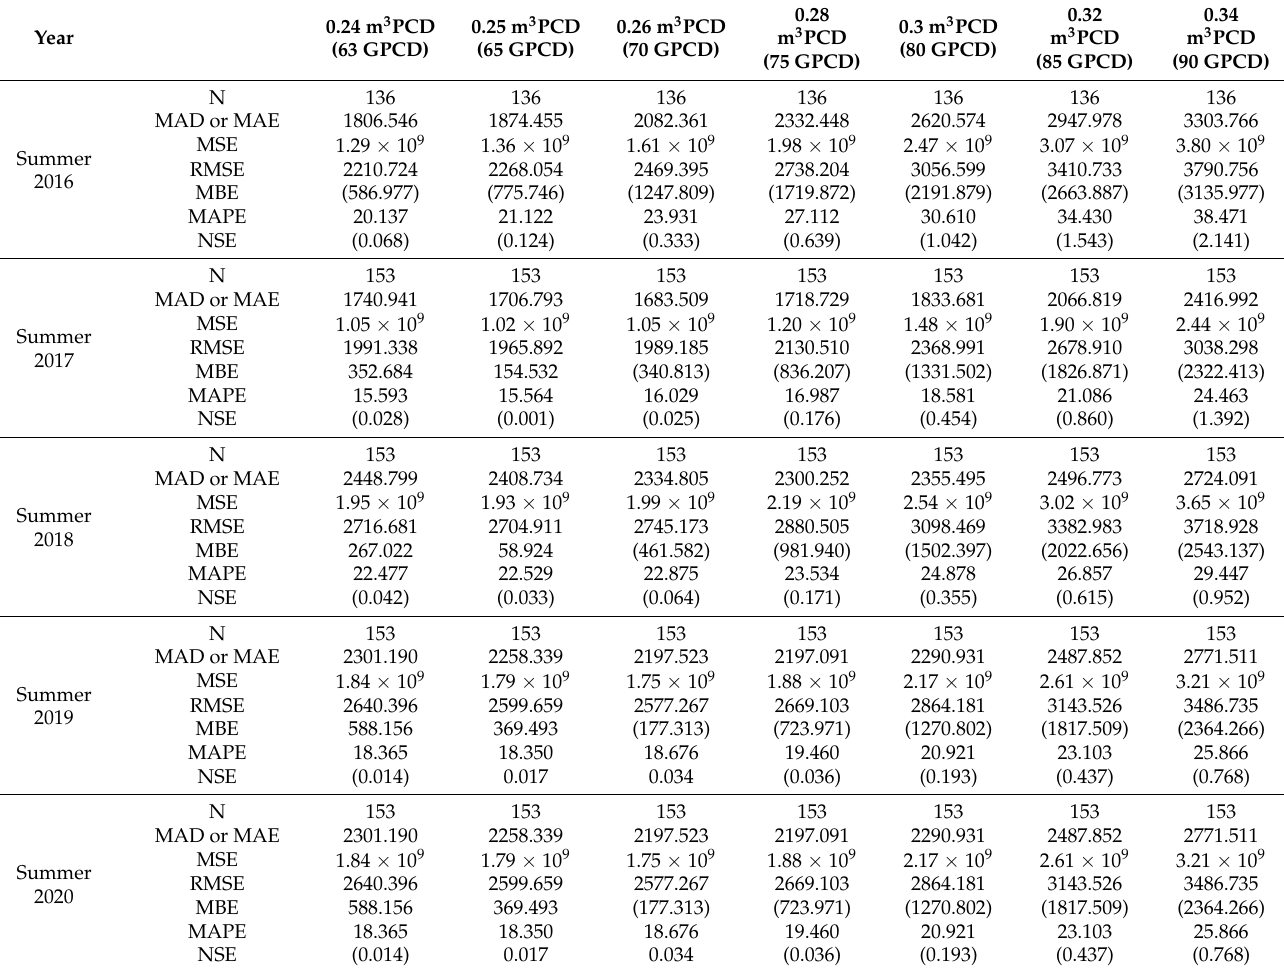
Table A1. Error Metrics while varying outdoor per capita demand values for summer season